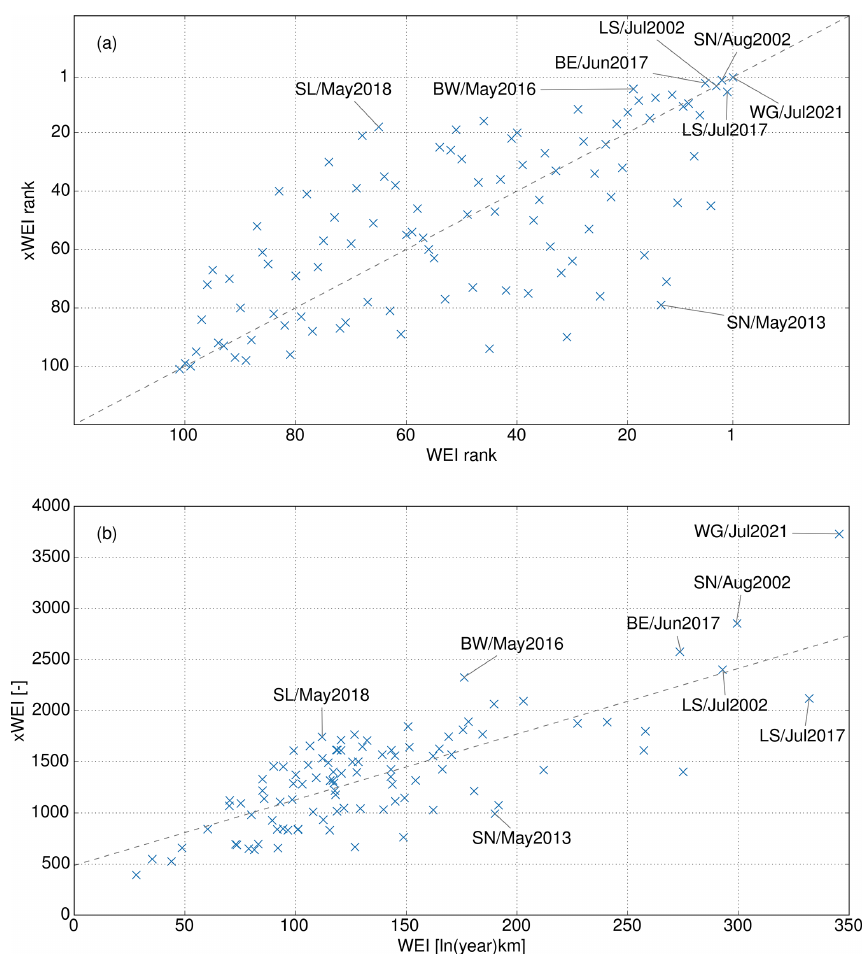
Figure 5. (a) The xWEI ranks plotted over WEI ranks. Please note that the values on both axes are decreasing in order to enhance the comparability to panel (b) , which shows xWEI values plotted over WEI